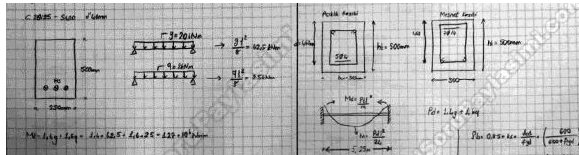
Figure 1. Portions of typical answer sheets of the reinforced concrete elements’ section calculations and moment diagram (Source: